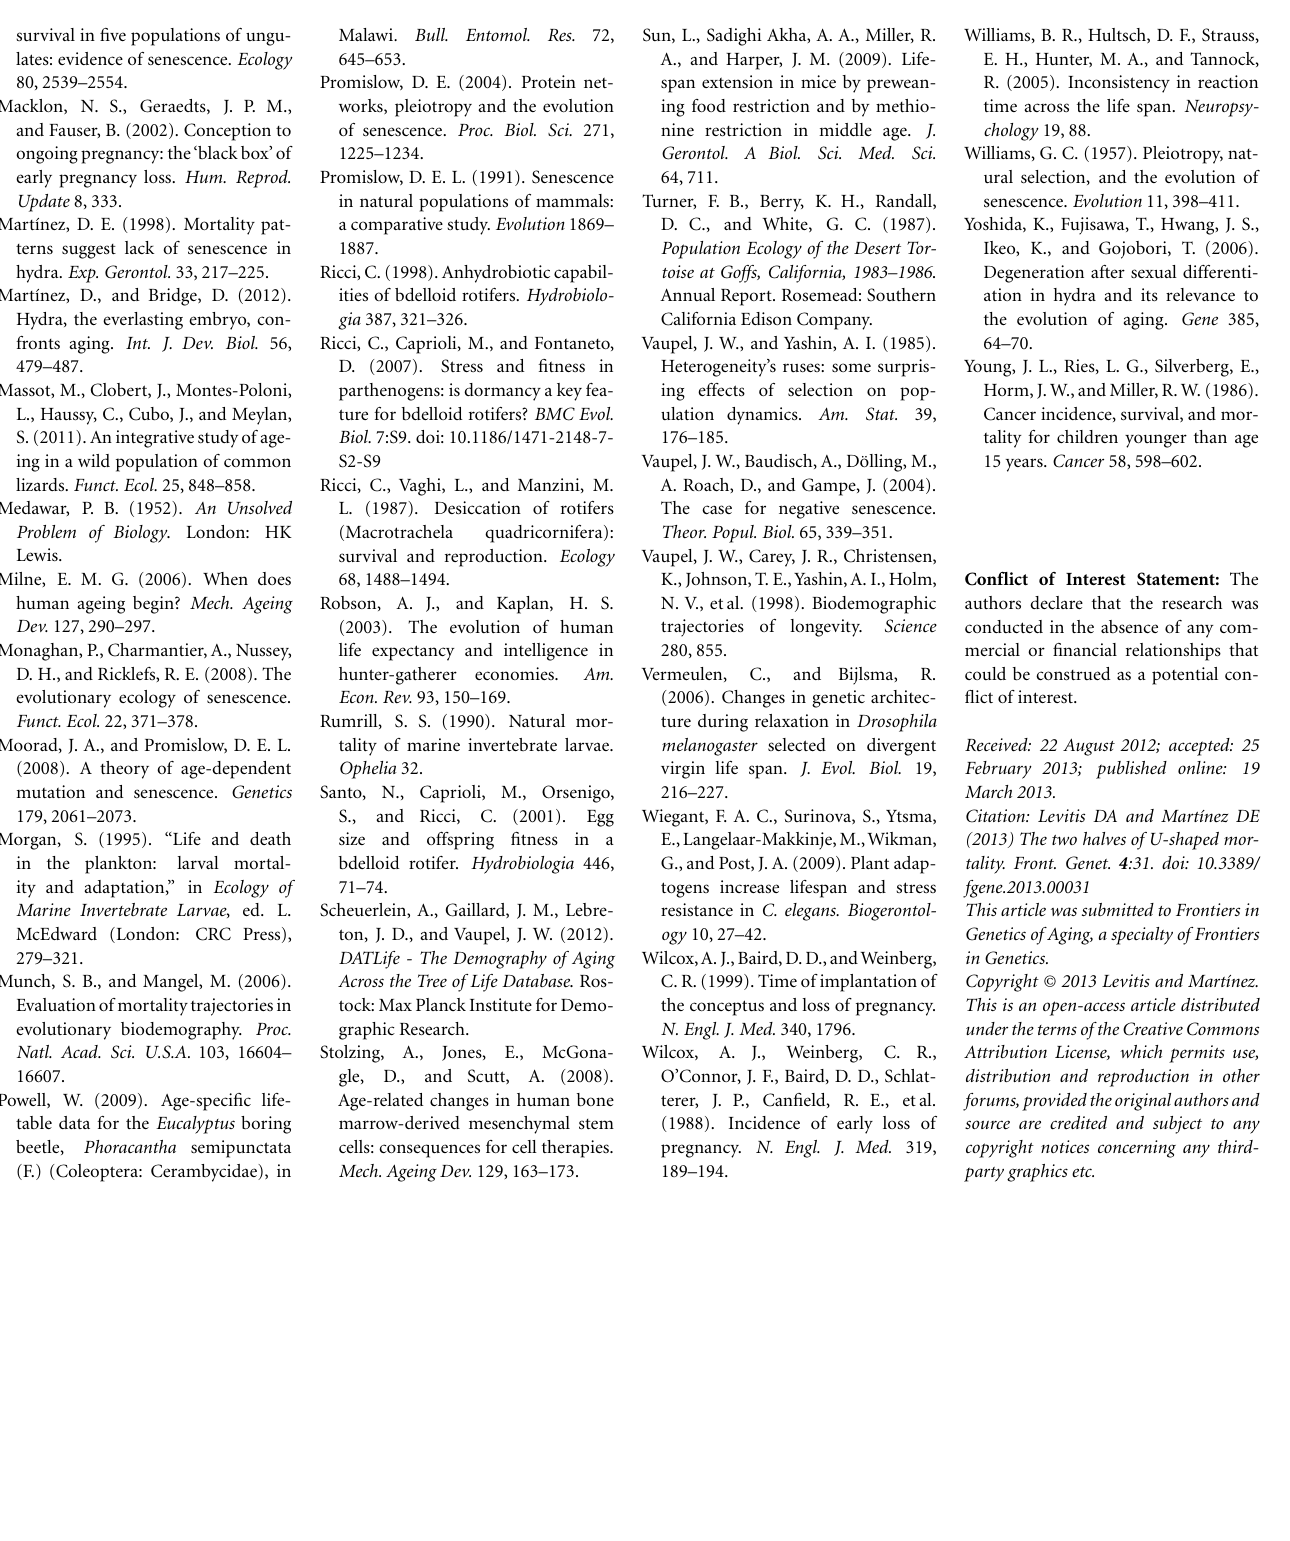
table data for the Eucalyptus boring beetle, Phoracantha semipunctata (F.) (Coleoptera: Cerambycidae),